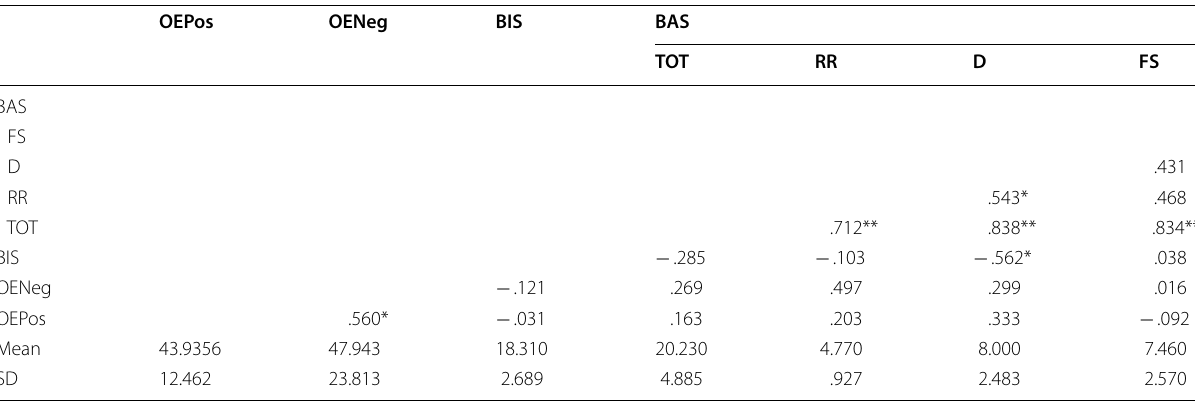
Table 3 Correlation matrix showing relationships between BIS Total, BAS Total, BAS subscales, and overestimation bias scores for men